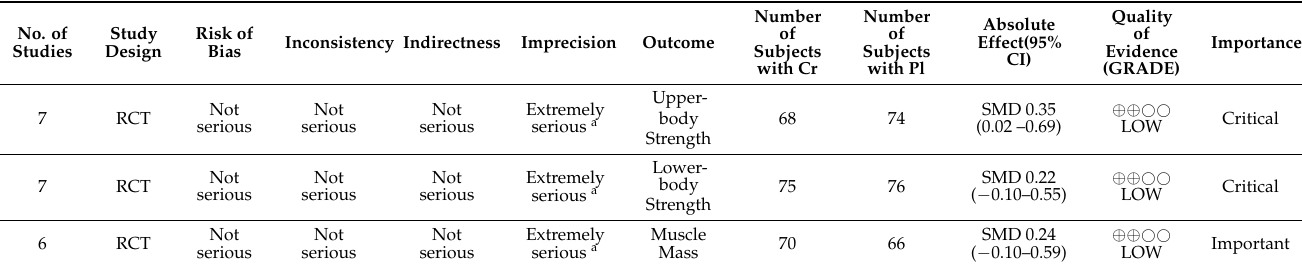
Figure 2. Forest plot for analysis of muscle strength of the lower body during the leg press or hack exercise, separated by subgroups according to study duration (up to 14 weeks and ≥ 24 weeks). Table 3. Summary of findings and quality of evidence (GRADE) for Cr.